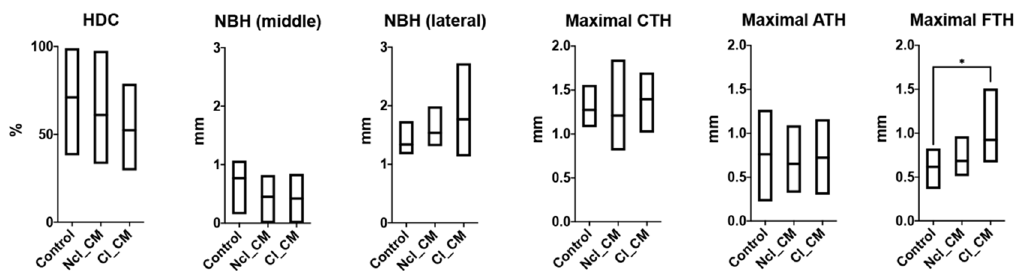
Figure 6. The magnified views of toluidine blue and fuchsin staining in the middle area at high magnification (500×) in ( A ) Control (empty), ( B ) Ncl_CM, and ( C , D ) Cl_CM groups at three months post-surgery. The yellow arrowheads show lymphocytes, red arrowheads indicate residual materials, and black arrowheads show multinucleated giant cells (MNGCs). Figure 7. Histomorphometry of linear parameters including horizontal defect closure (HDC, %), new bone height in the middle area (NBH middle, mm), NBH in the lateral area (NBH lateral, mm), maximal connective tissue height (Maximal CTH, mm), maximal adipose tissue height (Maximal ATH, mm), and maximal fibrous tissue height (Maximal FTH, mm) at three months post-surgery. * denotes significant difference between the groups; p < 0.05.